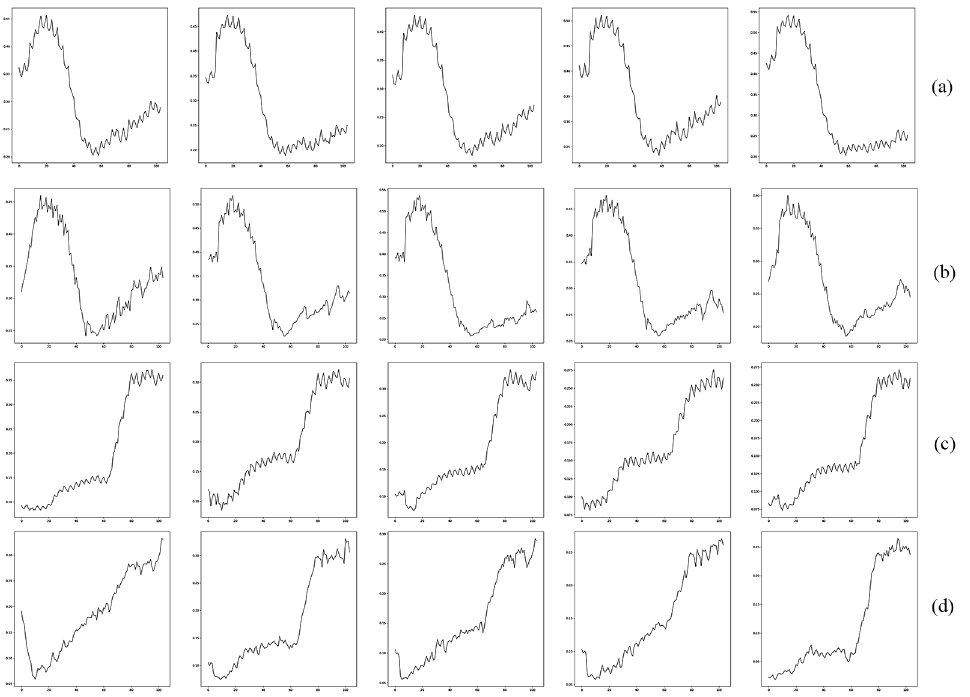
Figure 3. The spectral curves generated by SaGAAN with/without self-attention mechanism: ( a ) the Class 5 (Painted metal sheets) spectral curves generated without self-attention; ( b ) the Class 5 spectral curves generated with self-attention; ( c ) the Class 6 (Bare Soil) spectral curves generated without self-attention; and ( d ) the Class 6 spectral curves generated with